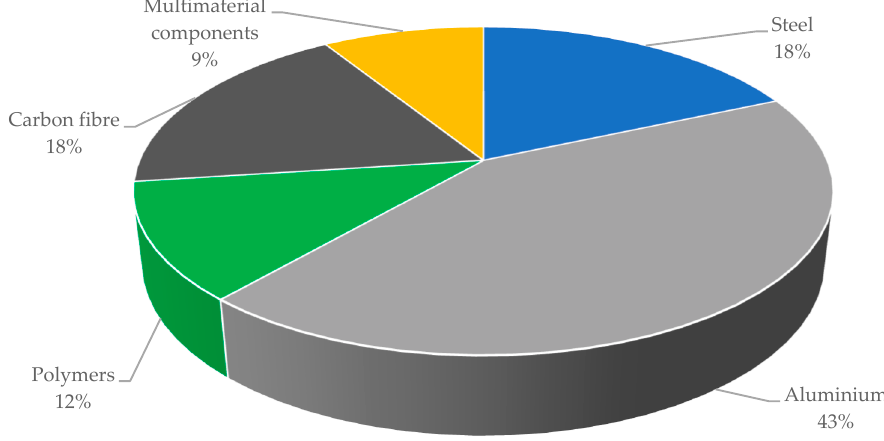
Figure 3. Percentage breakdown by weight of the materials that make up the analysed e-cargo bike.